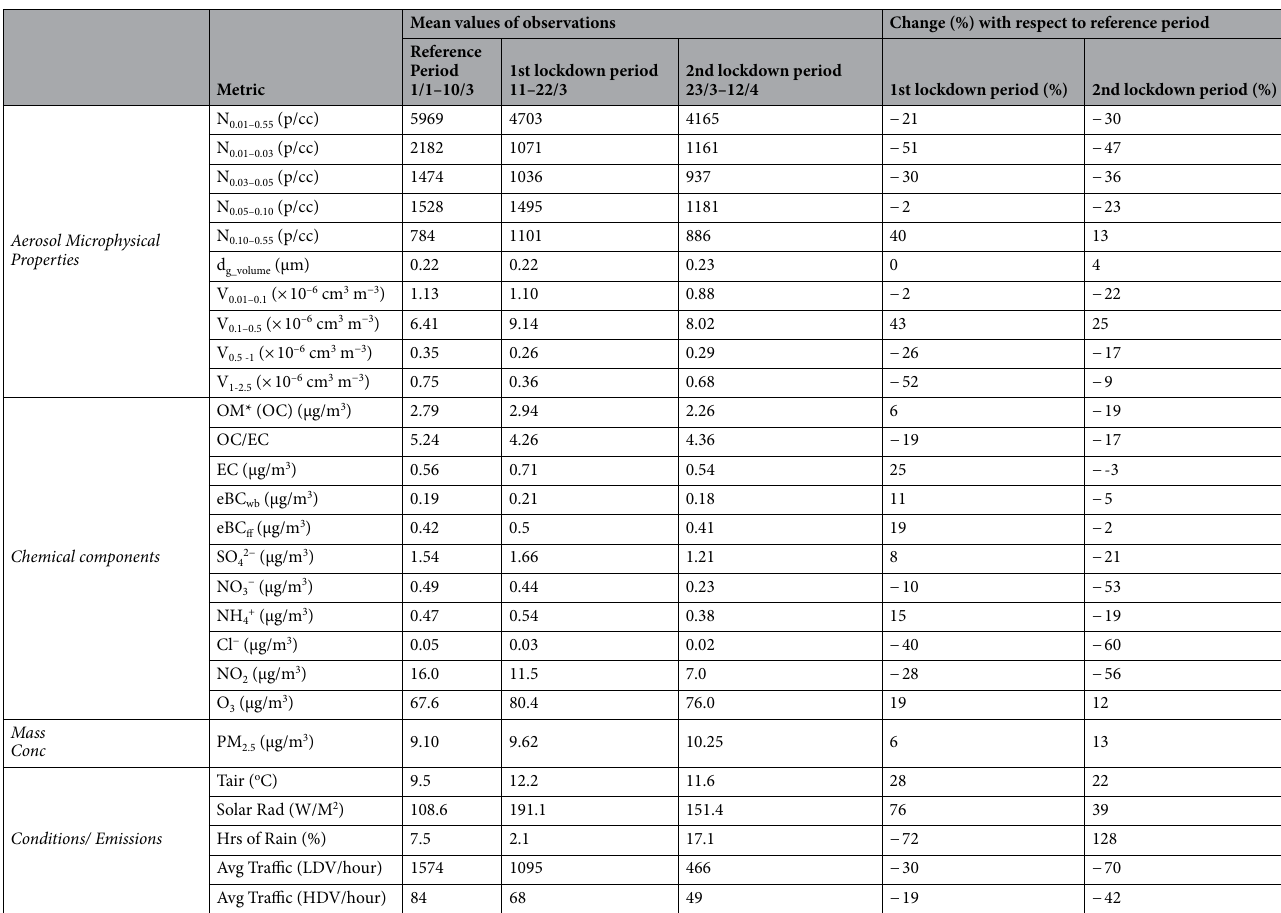
Table 1. Overview of Aerosol Microphysical and chemical parameters measured during the reference, 1st and 2nd lockdown periods as well as auxiliary parameters regarding atmospheric conditions and indicative traffic